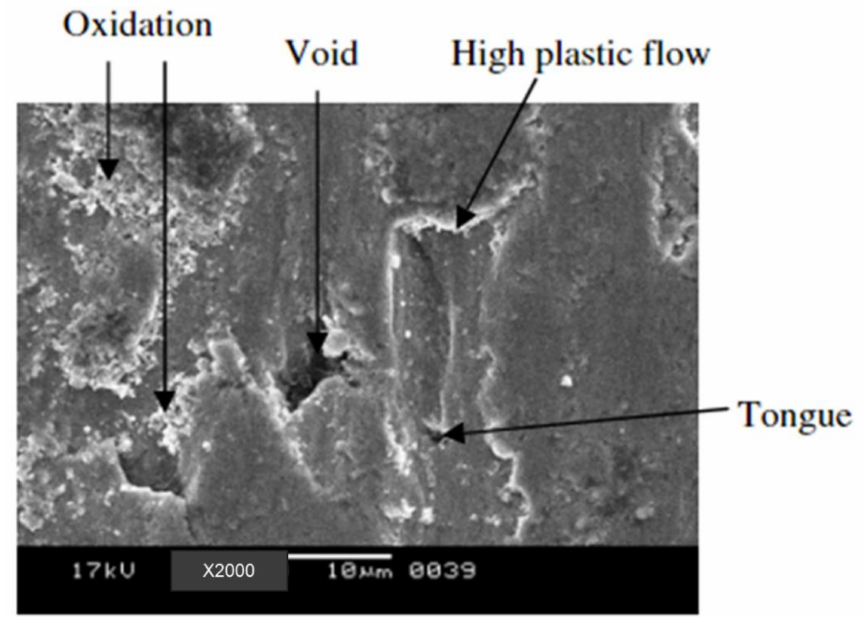
Figure 33. Worn surface micrograph of as-cast sample [44].